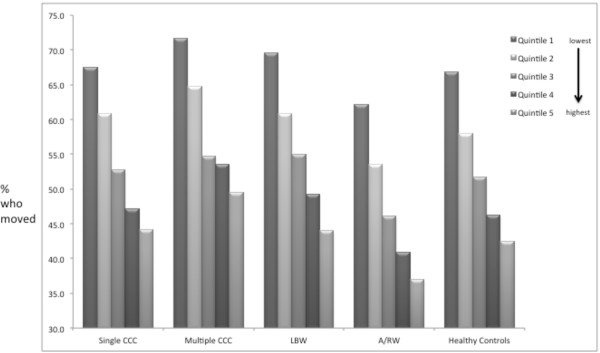
Rates of movement across chronic condition groupings and income quintile. Quintiles are arranged in ascending order. CCC = complex chronic condition(s), LBW = low birth weight, A/RW = asthma/recurrent wheeze.